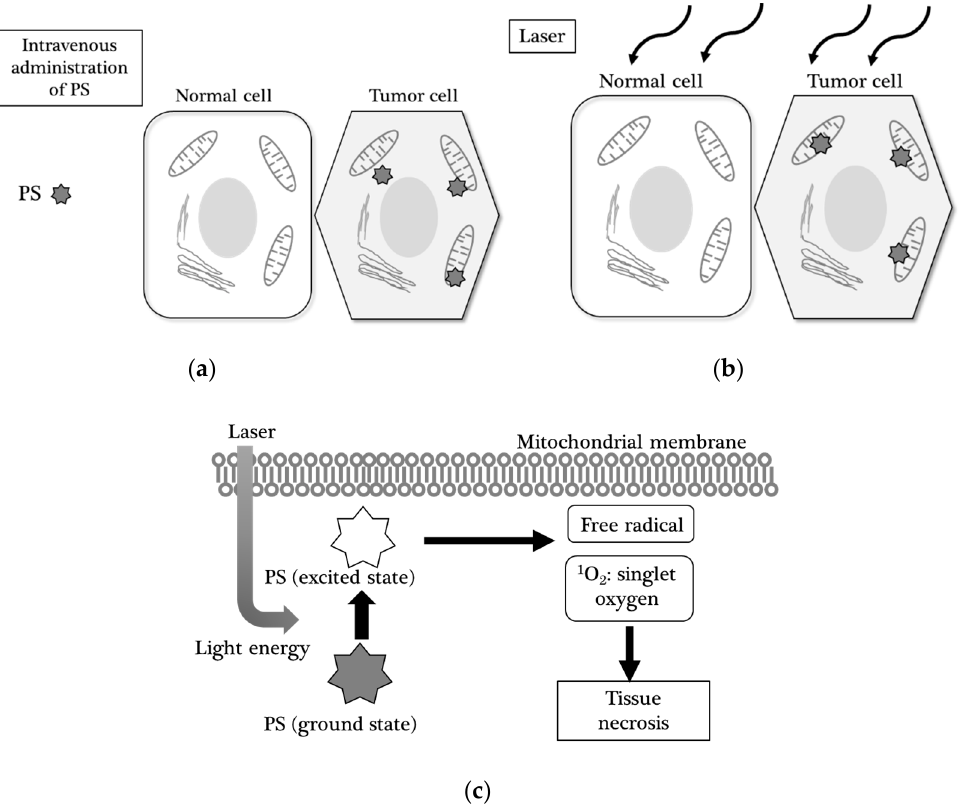
Figure 2. Mechanism of photodynamic therapy (PDT): ( a ) The photosensitizer (PS) is administered by intravenous injection and taken up specifically by the tumor cell (the hexagonal cell) and localizes in the mitochondria, but not in the normal cell (the squared cell); ( b ) Following irradiation of laser with a certain wavelength, the PS is excited; ( c ) in the mitochondria, an interaction occurs with reactive oxygen species including H 2 O 2 , OH - , leading to the formation of free radical and singlet oxygen ( 1 O 2 ).